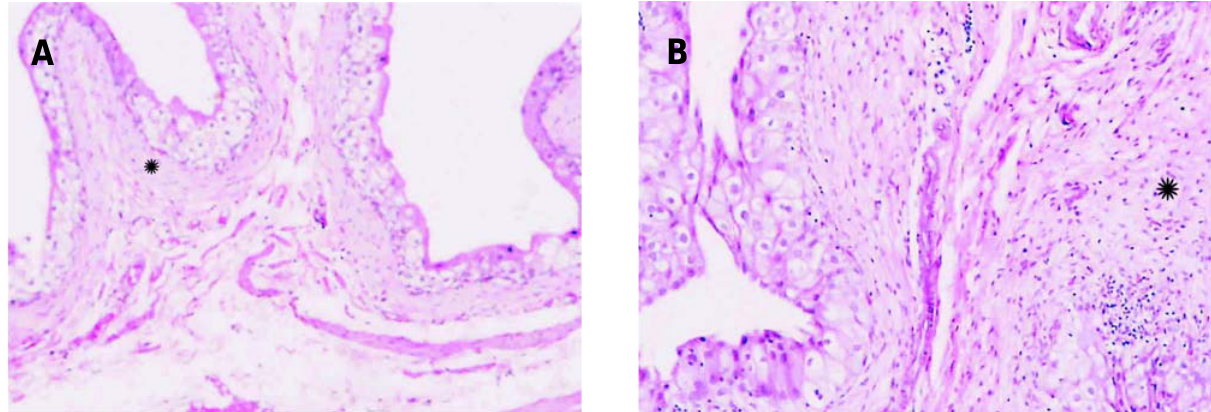
Figure 4 – Histological section of rabbit bladder. A) Absence of mucosa fibrosis in group G1 (asterisk), HE X100. B) Mild mucosa fibrosis (asterisk) in group G2, HE